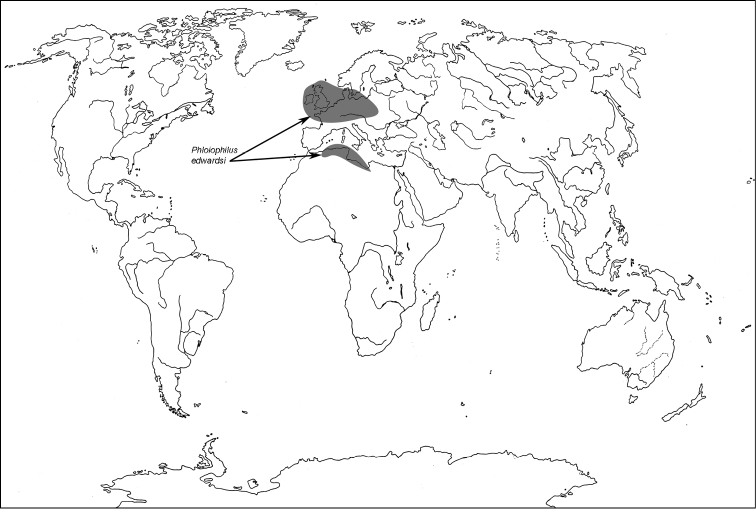
A distribution of the tribe Phloiophilini.